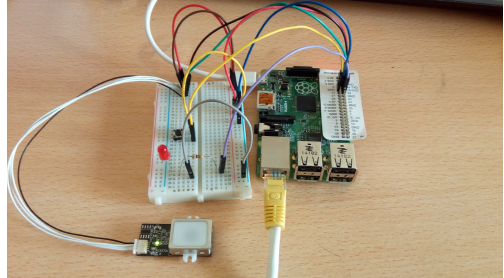
This image shows the physical connections between the Raspberry and the peripheral devices. The LED emulates the magnetic lock. An Ethernet connection is also needed because the Raspberry runs a Node.js web